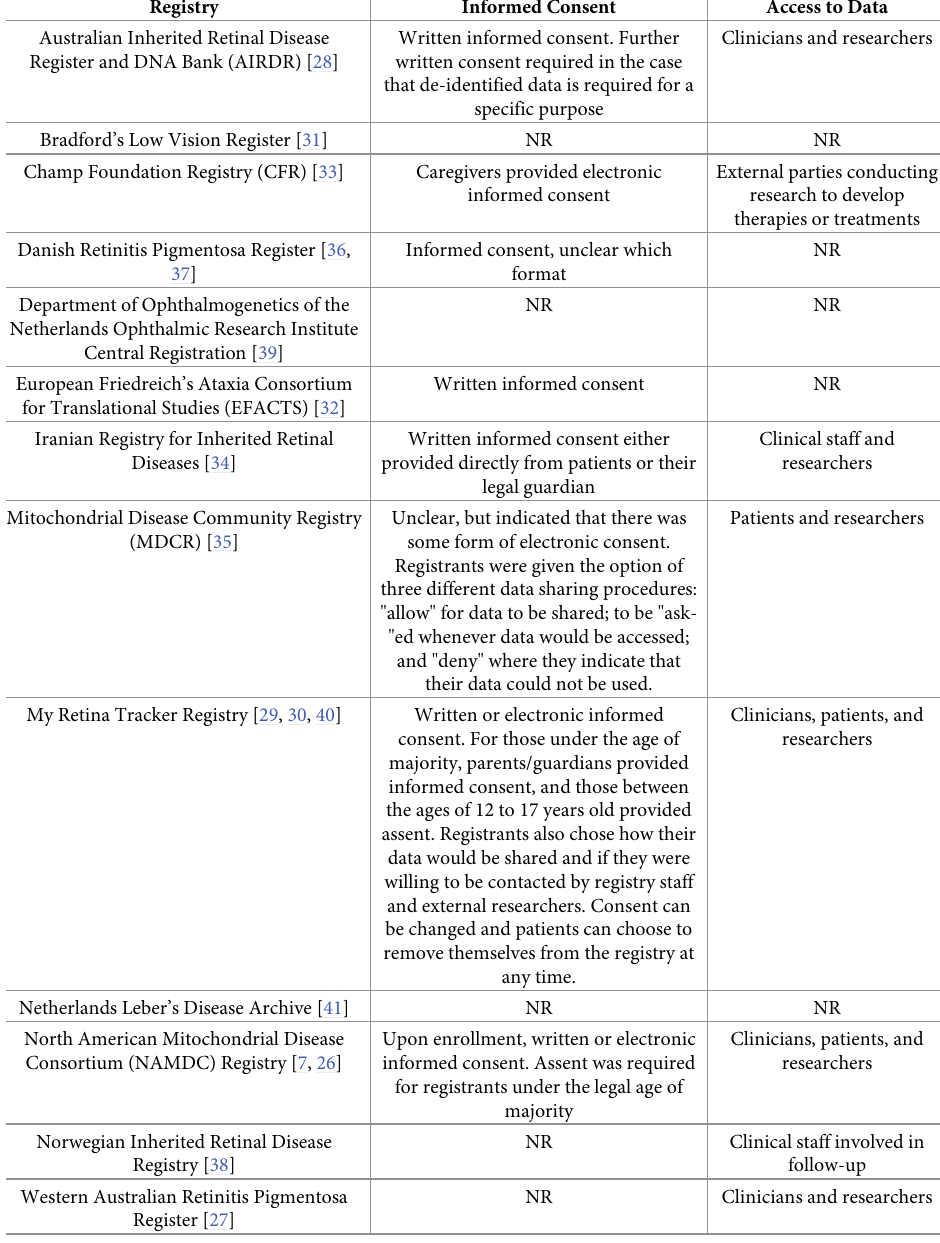
Table 3. Patient consent and stakeholder access to data within each Mitochondrial Disease (MD) patient